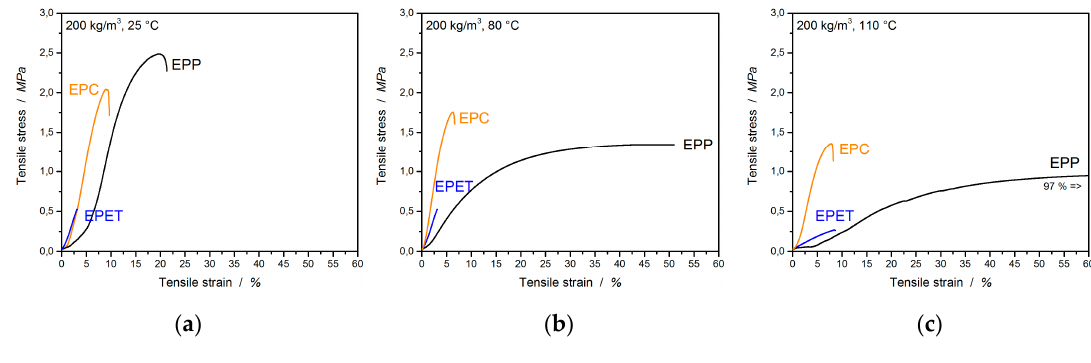
Figure 7. Tensile curves for EPC, EPP, and EPET at 25 ( a ), 80 ( b ), and 110 °C ( c ).